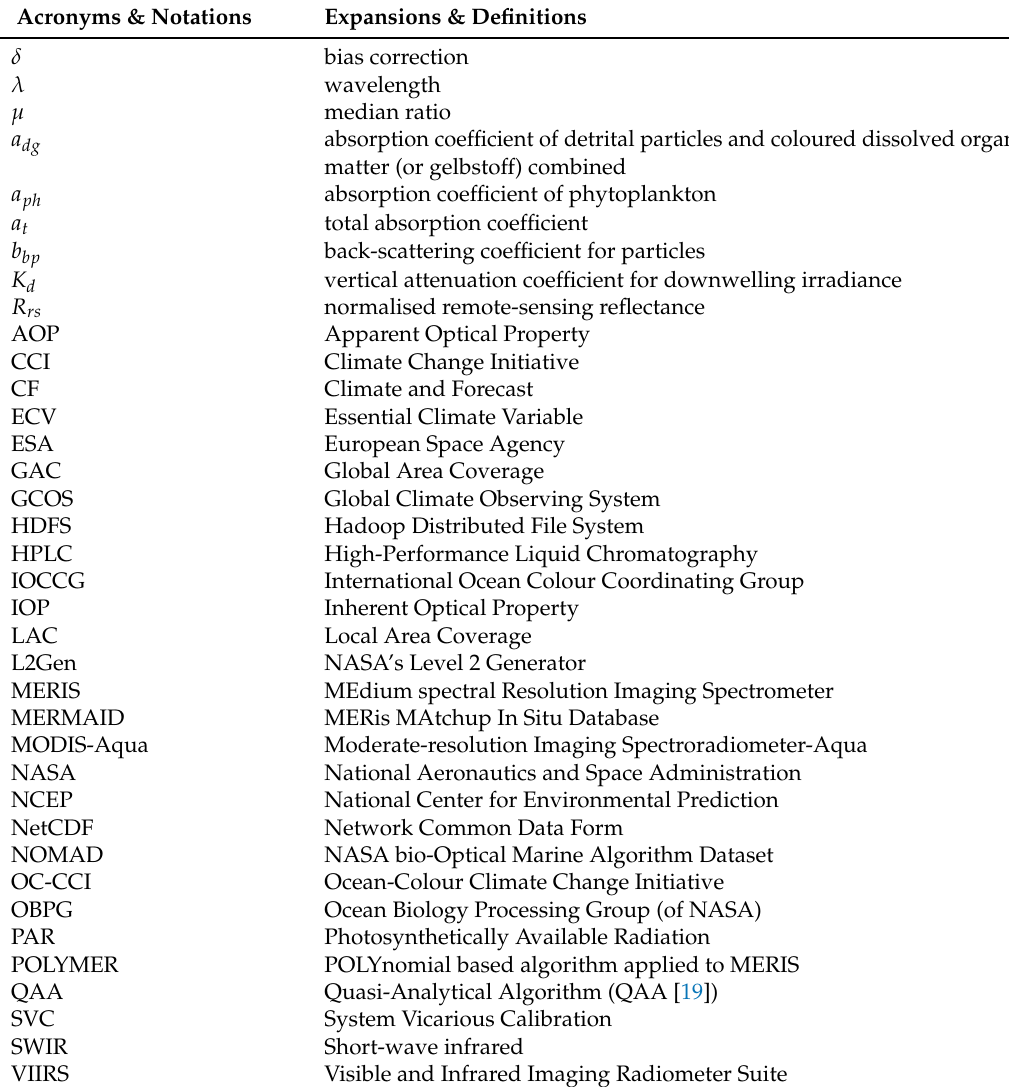
Table 1. List of acronyms and notations used and their expansions and